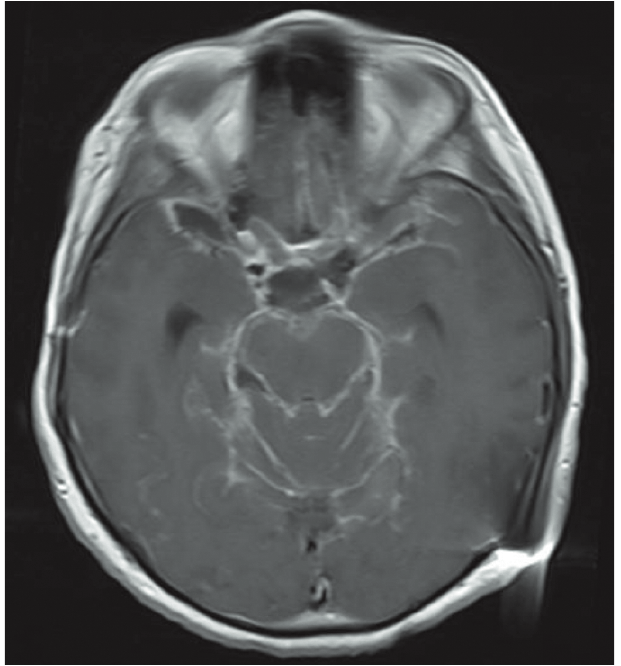
sylvian fissure.